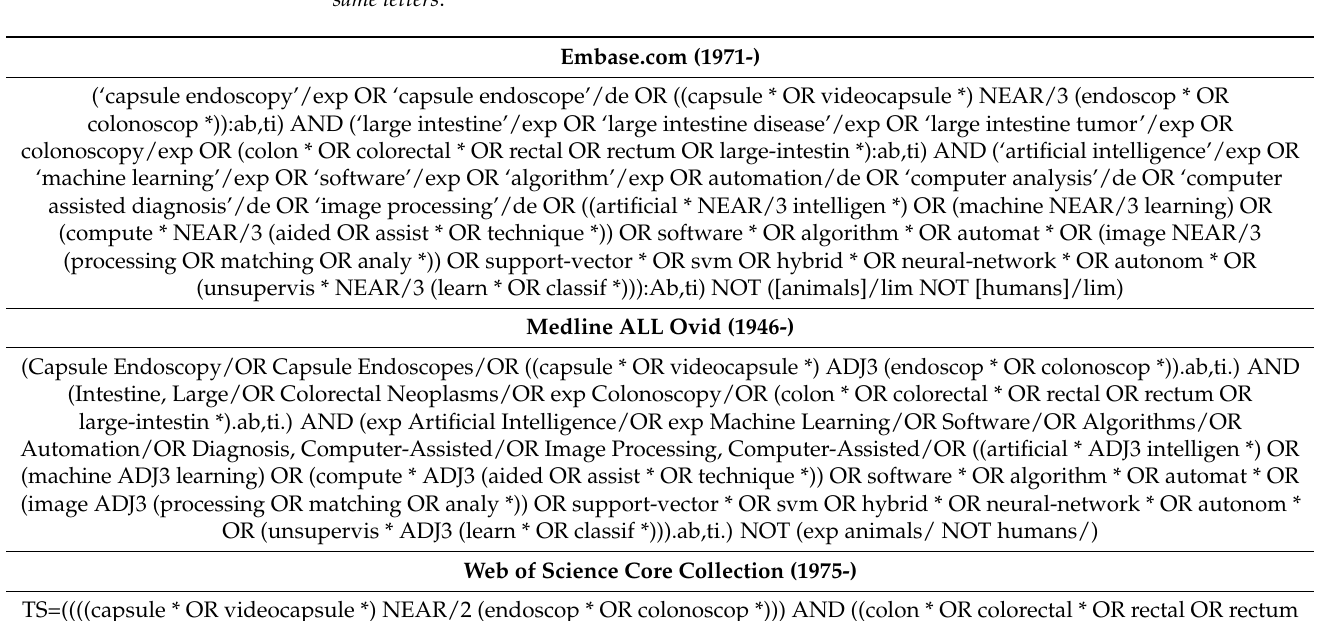
Table 1. Systematic literature search. * = symbol that broadens a search by finding words that start with the same letters